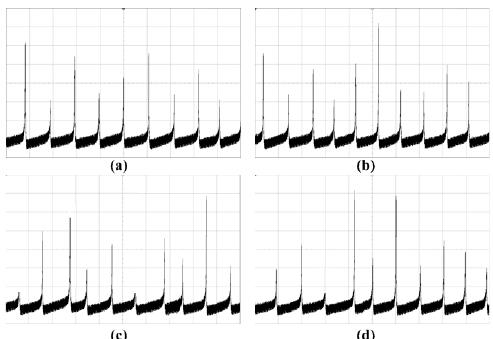
Figure 4. Biological behaviors of the hippocampal neural network implemented on Stratix III field programmable gate array (FPGA), which are observed on the oscilloscope device. The voltage scale is 50 mV. ( a ) The output of the 1st excitatory neuron in the digital neuromorphic network (time scale is 20 μ s); ( b ) The output of the 48,000th excitatory neuron in the digital neuromorphic network (time scale is 20 μ s); ( c ) The output of the 1st inhibitory neuron in the digital neuromorphic network (time scale is 20 μ s); ( d ) The output of the 16,000th inhibitory neuron in the digital neuromorphic network (time scale is 20 μ s).